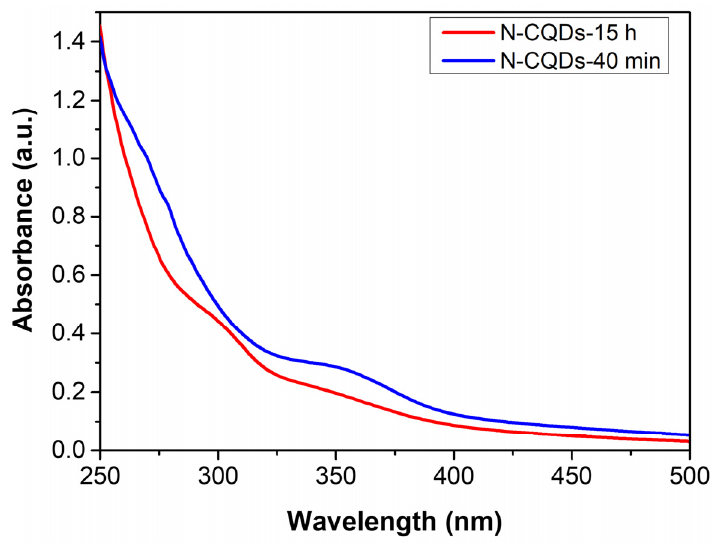
Figure 4. Absorption spectra of N-CQDs-40 min (blue solid line) and N-CQDs-15 h (red solid